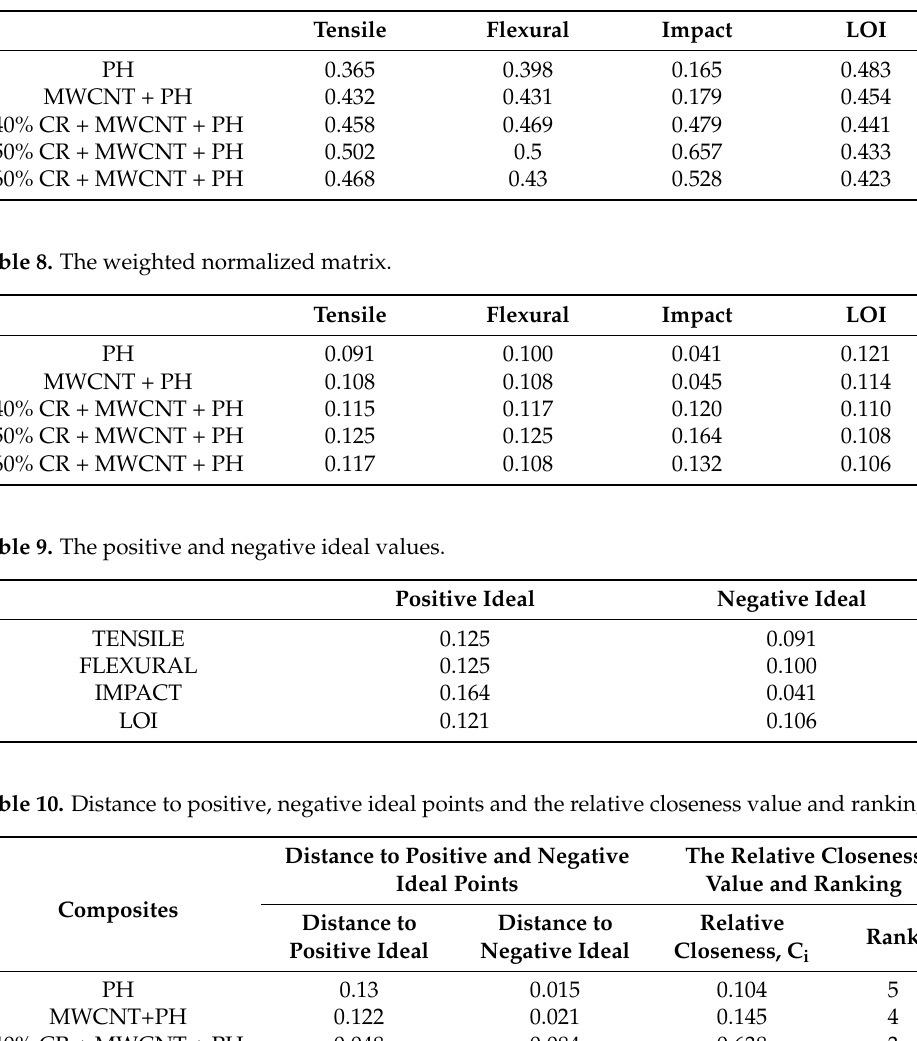
Table 7. The normalized matrix.